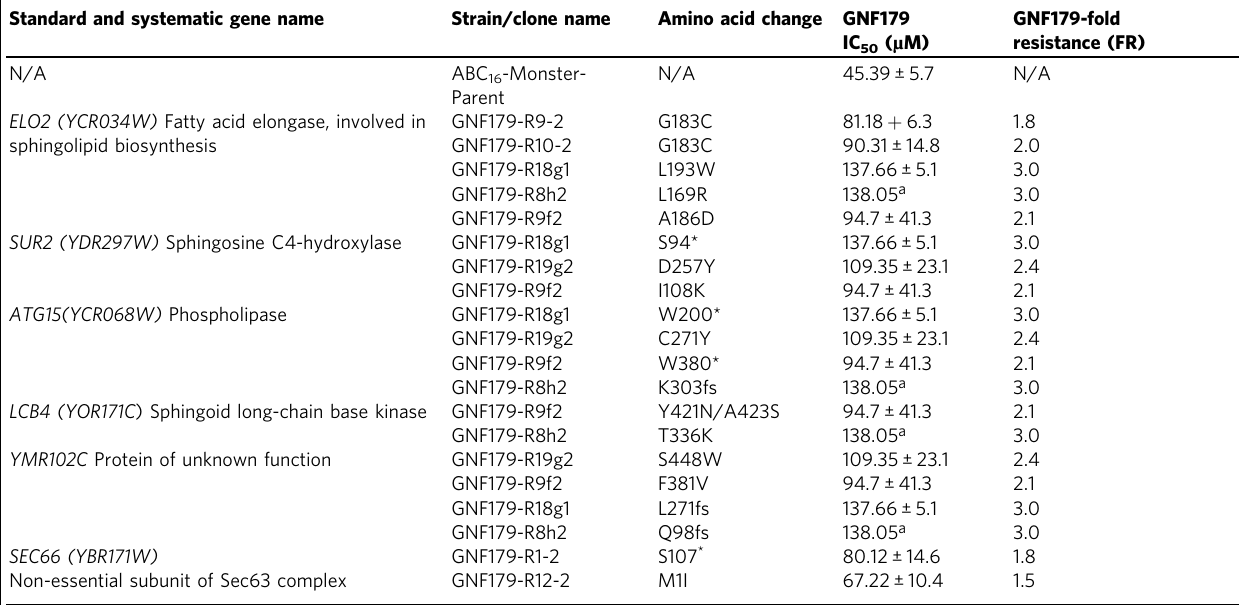
Table 1 Mutations identi fi ed in more than one GNF179-resistant S. cerevisiae line, from a pool of 13 evolved